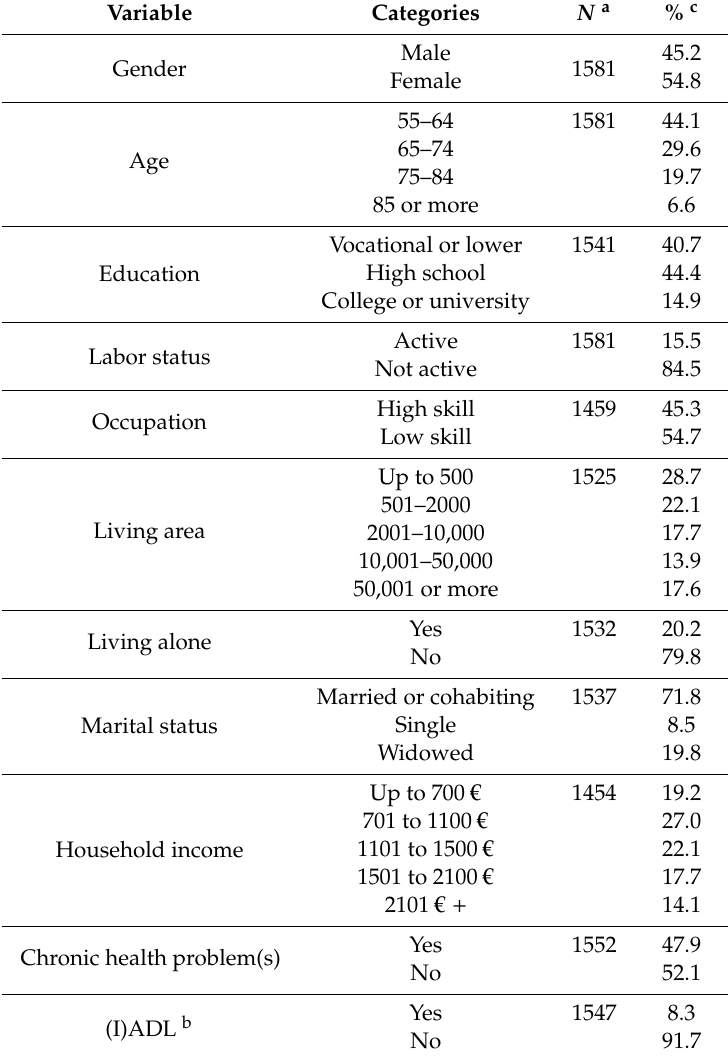
Table 1. Sample characteristics (weighted